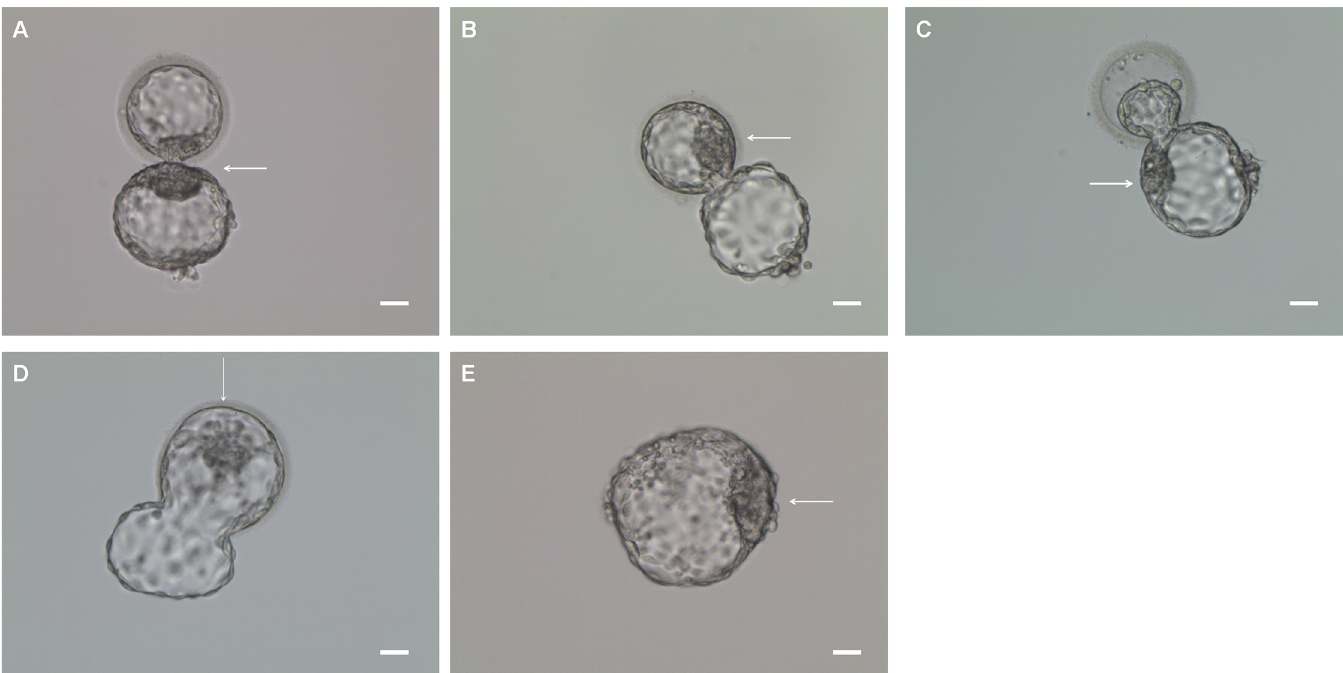
Fig 2. Three hatching types of PGD/PGS blastocysts before biopsy. Type I: Figure 8-shaped blastocysts with ICM incarceration (A) in which a part of TE cells were hatched out, but ICMs were trapped in the ZP opening (zona hole (cid:20) 30 μ m). Typically, ICM cells were split both inside and outside the ZP hole, but remained connected by a narrow bridge. Type II: Partially hatched blastocysts without ICM incarceration in which ICMs were inside (B) or outside(C) of the ZP opening, or the blastocysts hatched with a U-shape(D) (zona hole expanded > 30 μ m). Type III: Fully hatched blastocysts in which all TE and ICM cells were hatched out of zone(E). Arrow: inner cell mass. Bar = 30 μ m.